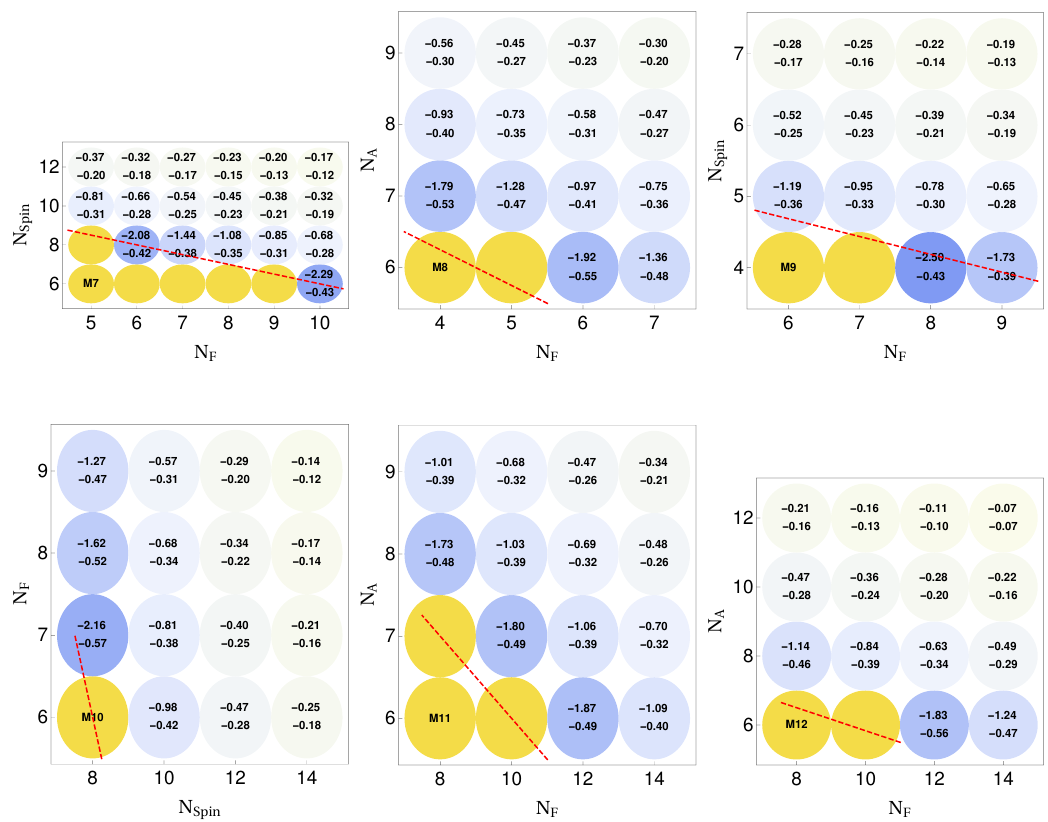
Figure 4: Models M7 to M12 and their neighbours with N ber of Weyl fermions in the X representation. Yellow circles represent potentially confining models whereas blue circles represent models likely to be in the conformal window, with the estimated maximal and minimal value of γ ∗ displayed. Our heuris- tic arguments for this classification are described in the text. The red dashed curve indicates the “conformal house” [ 21 ]